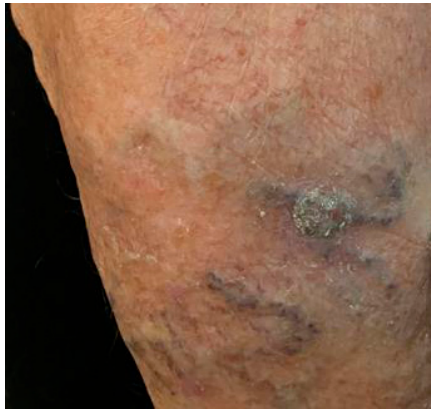
Figure 1. A grayish crusty and scaling plaque with a 30 mm of diameter was detected on the anterior middle third of the left leg.